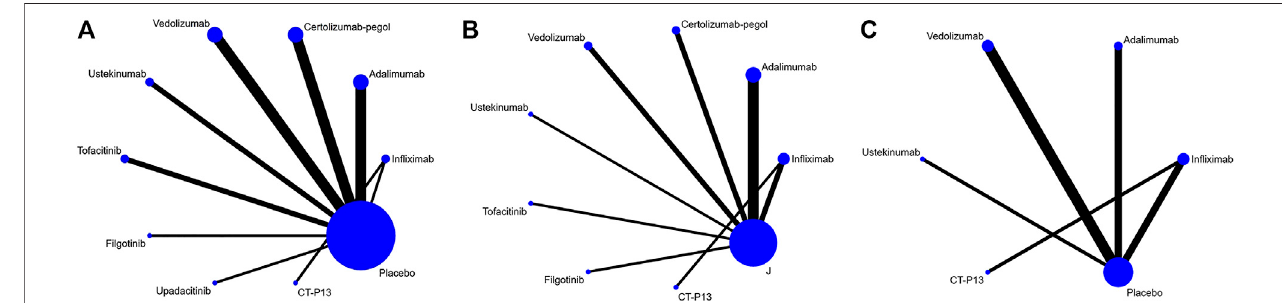
FIGURE 1 | Network plot for (A) induction of remission (B) maintenance of remission (C) steroid-free remission.